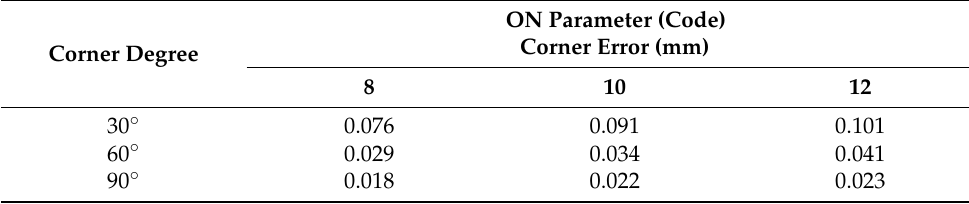
Table 6. Pulse-on time (ON) vs. corner